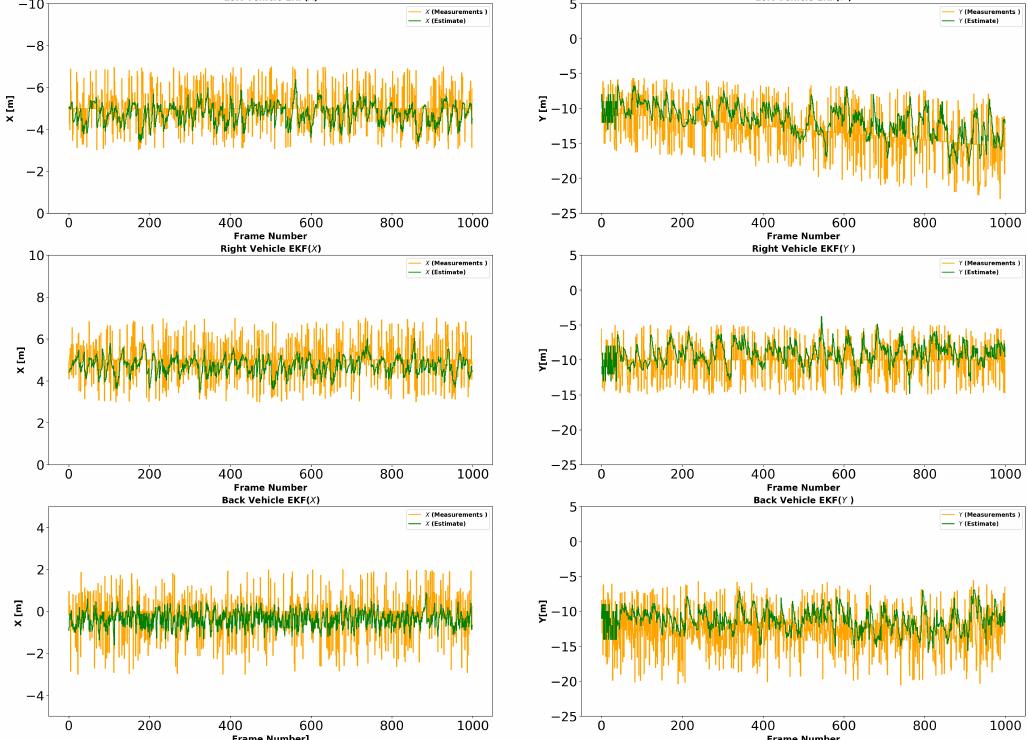
Figure 6. Experiment II (trajectory estimation in simulation) results. Relative position of host vehicle and target vehicles estimated by the proposed model. Relative position error with sensor-only observation is shown in orange, and relative position error after correction by the model is shown in green. We observe that the filter is able to smooth the relative positions of the target vehicles. The green, cyan, and orange paths show target vehicle paths with filtering. The red, magenta, and yellow lines are the estimated paths of the target vehicles without filtering. The graphic on the right magnifies the graphic on the left in the range: x ∈ [100...300], y ∈ [500...800]. Target vehicle paths are smoother under the proposed